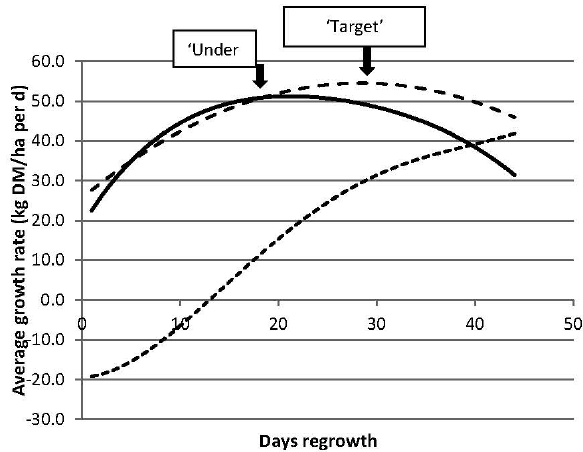
Figure 2. Average growth rate during regrowth for pastures mown to about 1150 (“Over”, dotted line), 1500 (“Target”, dashed line) or 1850 (“Under”, solid line) kg·DM/ha. Arrows indicate the point when the maximum average growth rate was reached during regrowth in the “under” and “target” treatments. The curves, and the point of maximum average growth rate, are derived from the fitted curves shown in Figure 1.